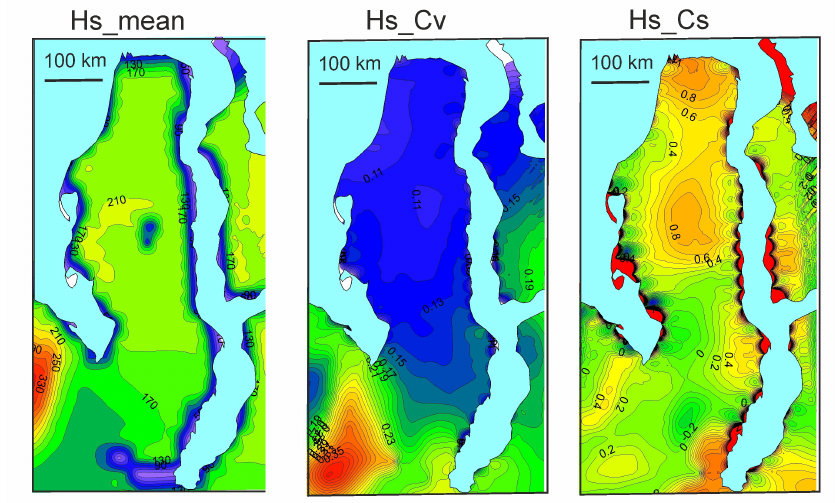
Figure 20. Spatial distributions of mean annual H s , its temporal variability C v and skewness C s. on